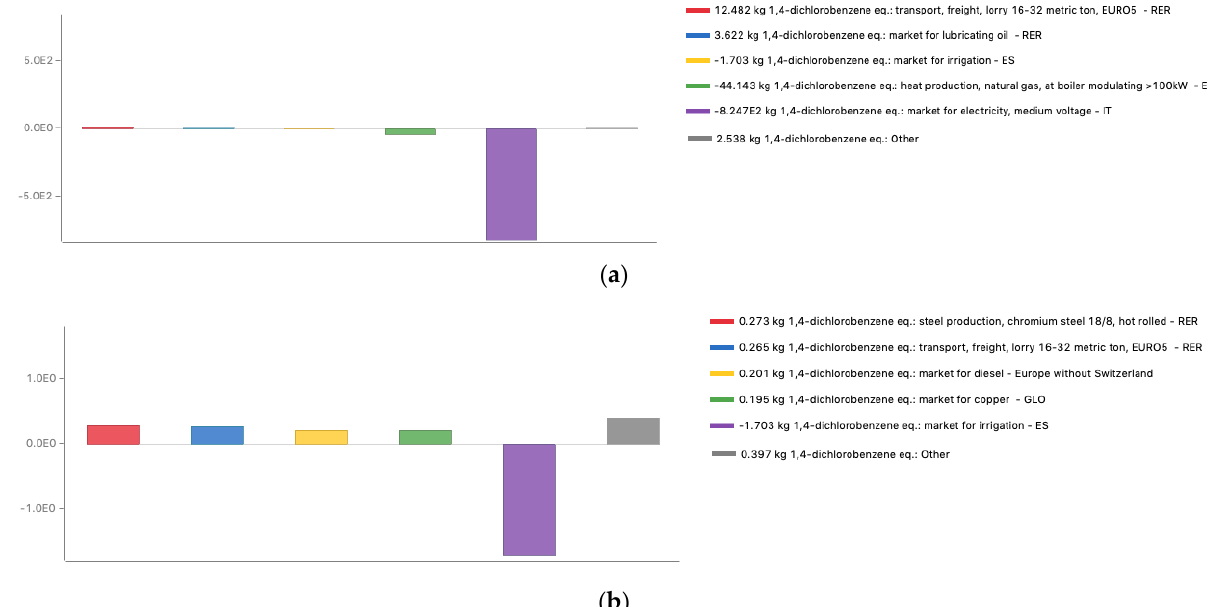
Figure 8. Freshwater Aquatic ecotoxicity: top 5 contributions impacting category results: ( a ) Cradle-to-grave analysis; ( b ) Downstream process.